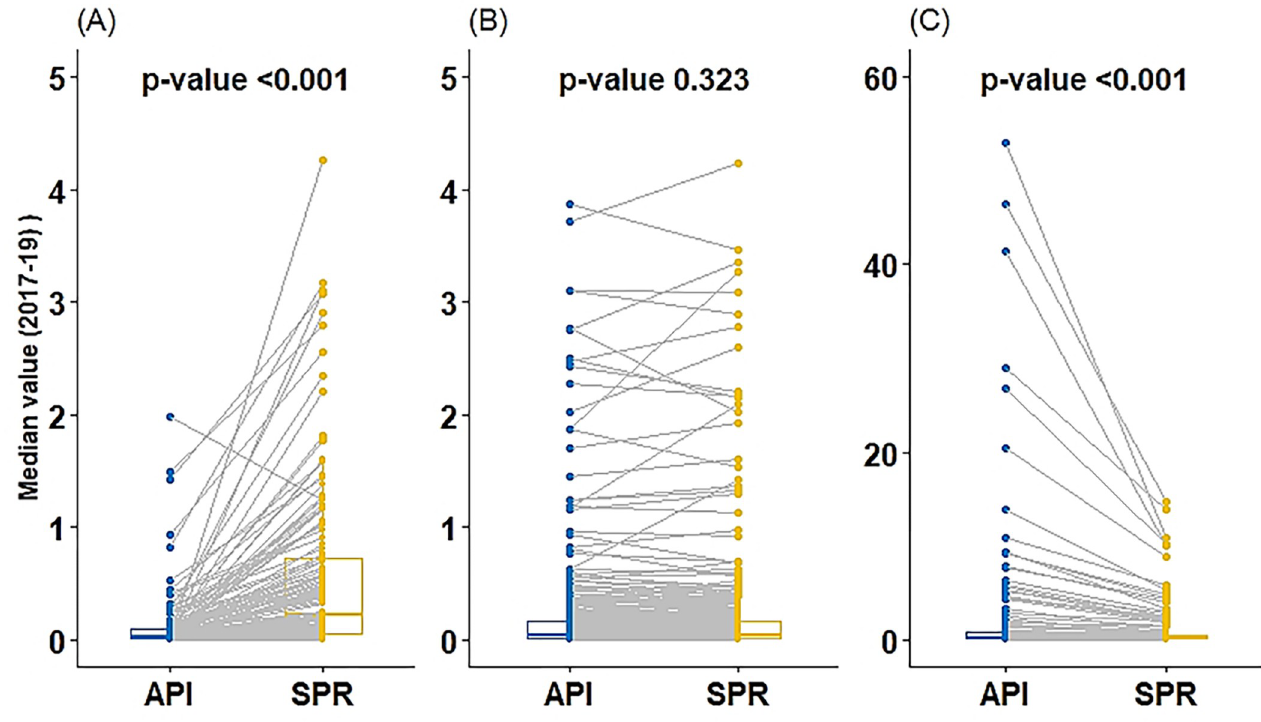
Fig 1. Comparison of API and SPR in three stratums of ABER based on district-level data of India (686 districts). API: Median Annual Parasite Incidence (2017–19); SPR: Median Slide Positivity Rate (2017–19) (A): Comparison of API and SPR in first stratum of ABER (i.e., ABER < 5) (B): Comparison of API and SPR in second stratum of ABER (i.e., 5 � ABER � 15) (C): Comparison of API and SPR in third stratum of ABER (i.e., ABER > 15).